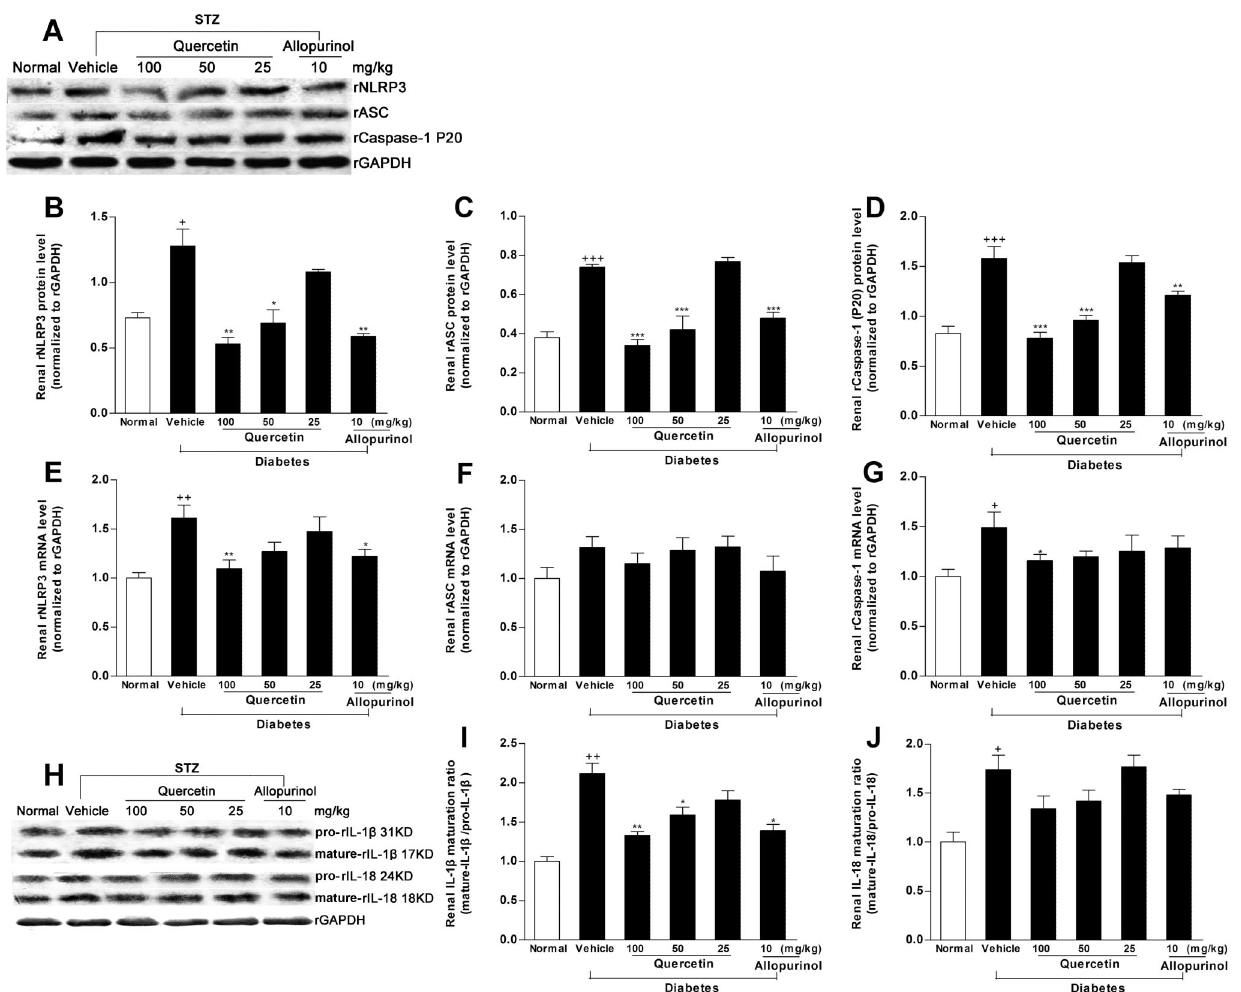
Figure 10. Quercetin and allopurinol inhibit renal NALP3 inflammasome activation in streptozotocin (STZ)-treated rats. Representative Western blot results (A) and graphic presentation showed renal protein expression of rNALP3 (B), rASC (C) and rCaspase-1 (D) in different groups of rats as indicated. Relative protein levels of rNALP3, rASC and rCaspase-1 were determined after normalization with rGAPDH. For rCaspase-1, the active subunit of P20 was detected. The data are expressed as the means 6 SEM (n=3–4). + P , 0.05, +++ P , 0.001 versus normal control; * P , 0.05, ** P , 0.01, *** P , 0.001 versus STZ control. Graphic presentation of renal mRNA levels by real-time PCR analysis of rNALP3 (E), rASC (F) and rCaspase-1 (G) at 7 weeks after STZ injection in different groups of rats as indicated. The relative mRNA levels were determined after normalization with rGAPDH. The data are expressed as the means 6 SEM (n=3–4). +++ P , 0.001 versus normal control; * P , 0.05, ** P , 0.01, *** P , 0.001 versus STZ control. Representative Western blot results (H) and graphic presentation showed renal maturation ratio of IL-1 b (I) and IL-18 (J) in different groups of rats as indicated. The data are expressed as the means 6 SEM (n=3–4). + P , 0.05, ++ P , 0.01 versus normal control; * P , 0.05, ** P , 0.01 versus STZ